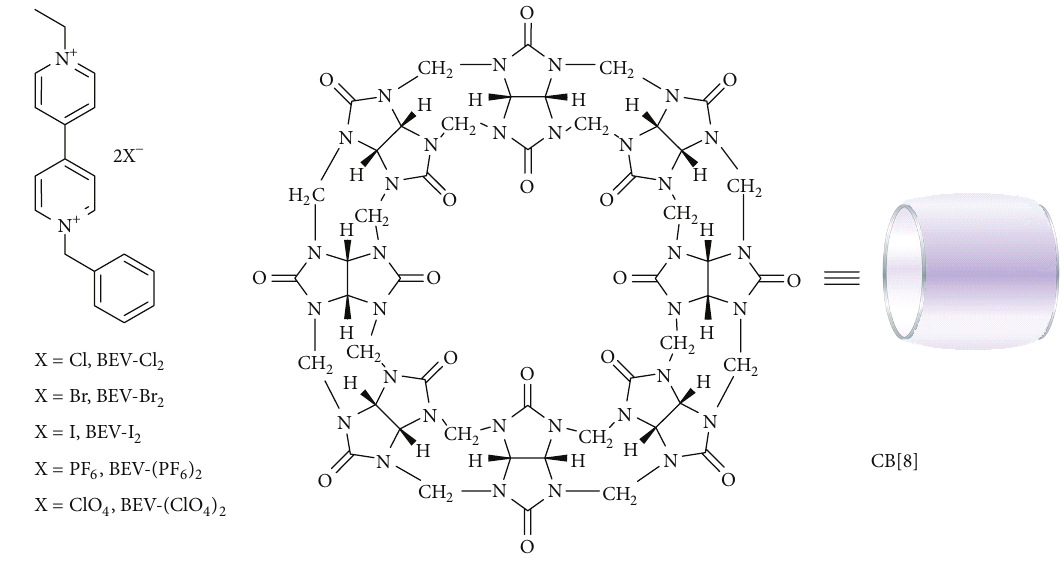
Figure 1: Structure of BEV-X 2 and CB [8] .